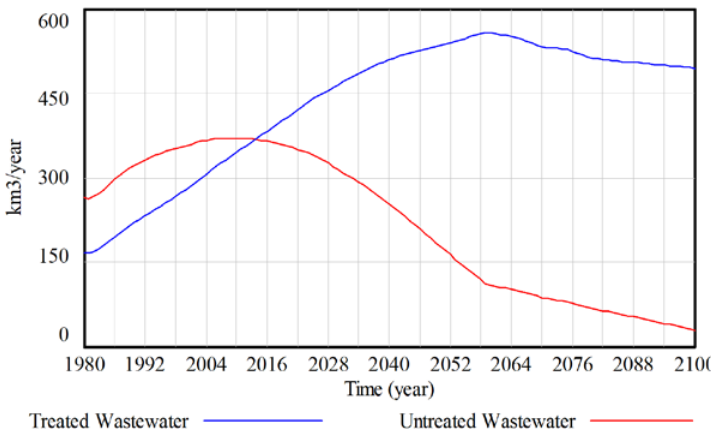
Figure 9. Treated and untreated wastewater inputs to the nutrient cycles over time .